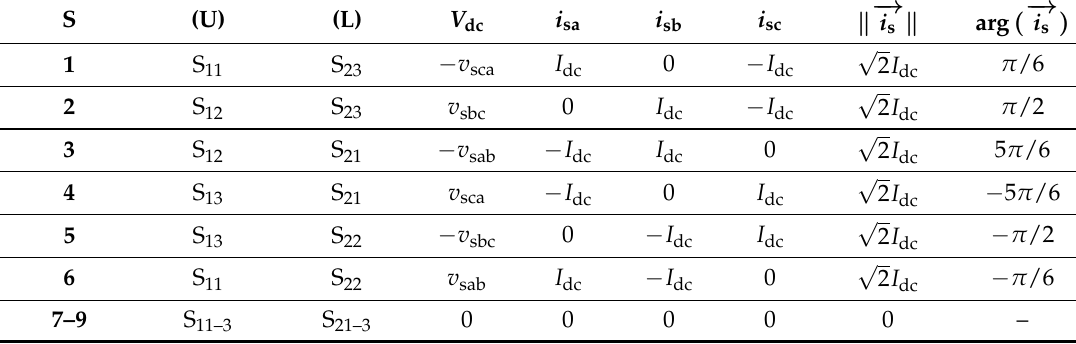
Table 1. Switching states of the shunt converter with the switches conducting on the upper (U) and lower (L) branch, with their effect on ‘dc link’ voltage and ac